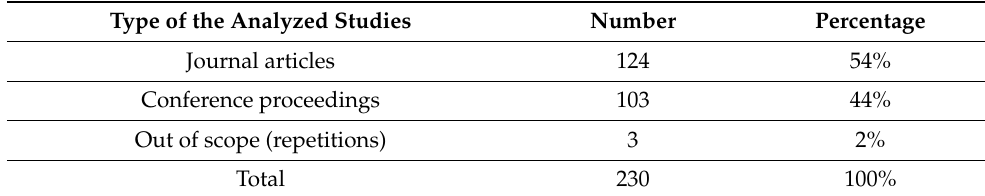
Figure 2. Publication period of analyzed studies. Table 1. Types of the located studies.